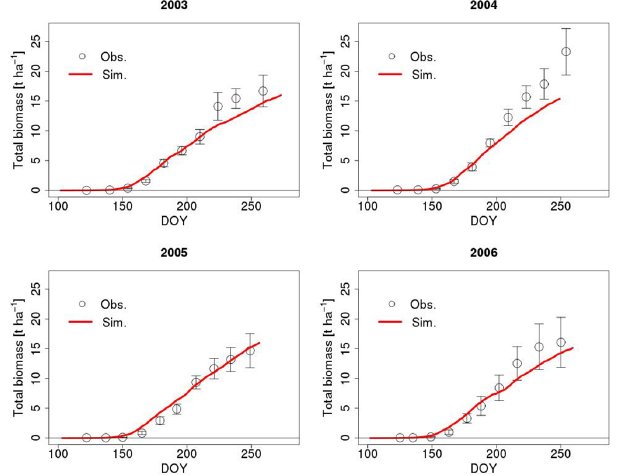
Figure 11. Comparison of total biomass between simulations and observations during growing periods from 2003 to 2006. Circles in- dicate mean values of observations and the ranges indicate standard deviation of observations. Red lines denote simulations. DOY indi- cates the number of days from 1